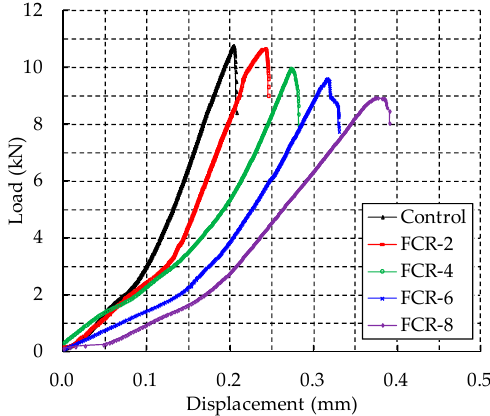
Figure 10. Load-displacement curves of fine crumb rubber (FCR)-modified mixtures.